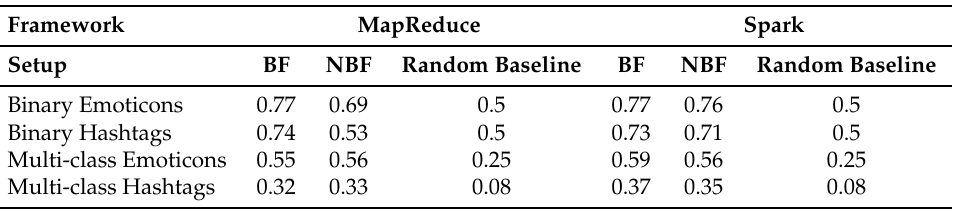
Table 2. Classification results for emoticons and hashtags (BF stands for Bloom filter and NBF for no Bloom filter).